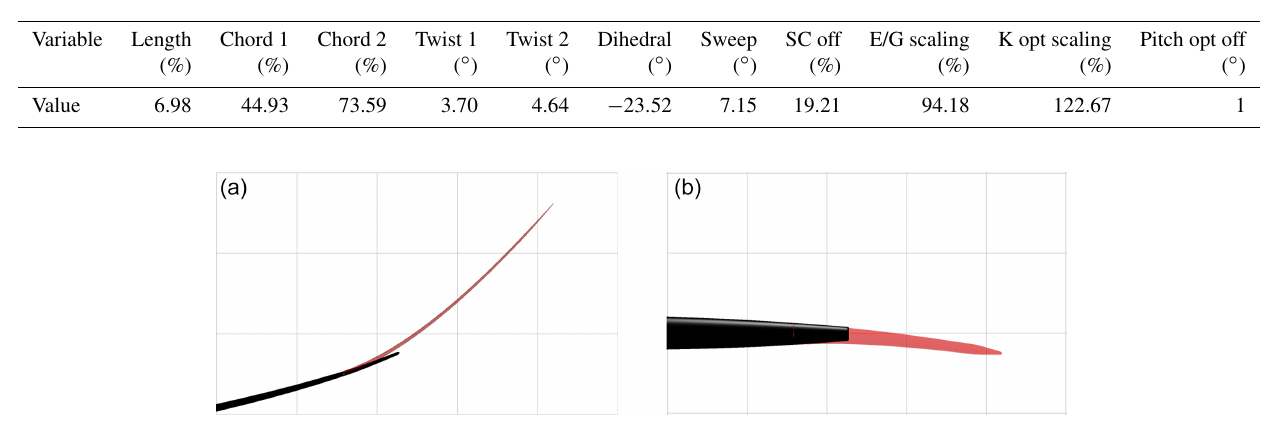
Table 2. Optimized design variables.